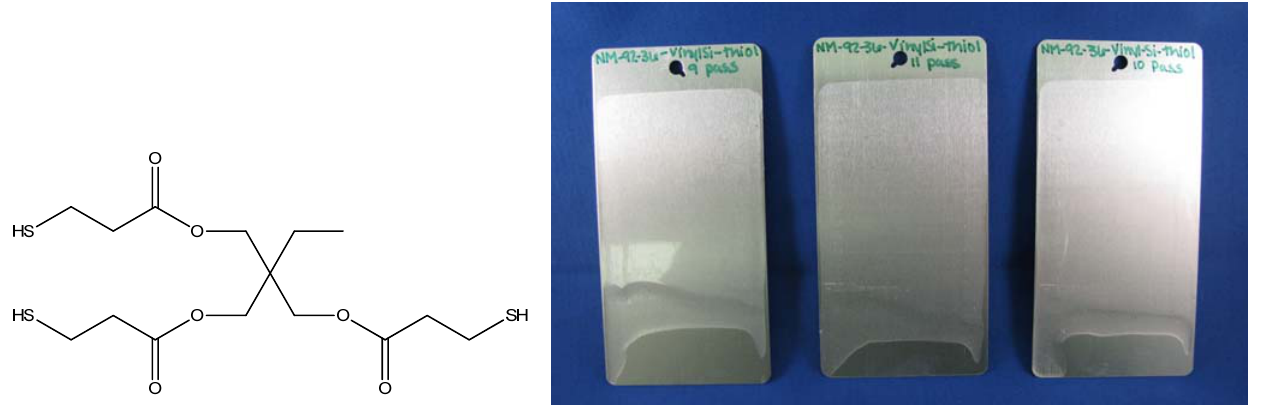
Figure 1. Chemical structure of trimethylolpropane tris(3-mercaptopropionate) (tri-thiol) and representative thiol-ene hydrolyzable networks, drawn on aluminum coupon substrates and cured to a dry film thickness of 0.1